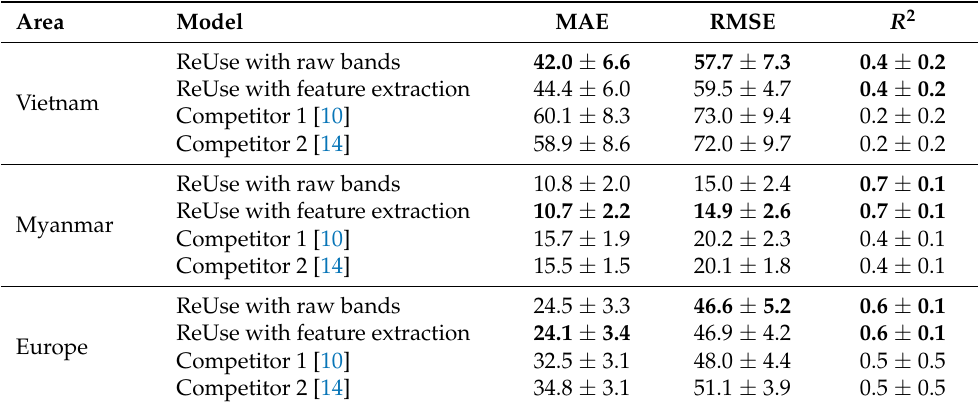
57.7 ± 7.3 42.0 ± 6.6 59.5 ± 4.7 44.4 ± 6.0 73.0 ± 9.4 60.1 ± 8.3 72.0 ± 9.7 0.2 ± 0.2 58.9 ± 8.6 24.5 ±